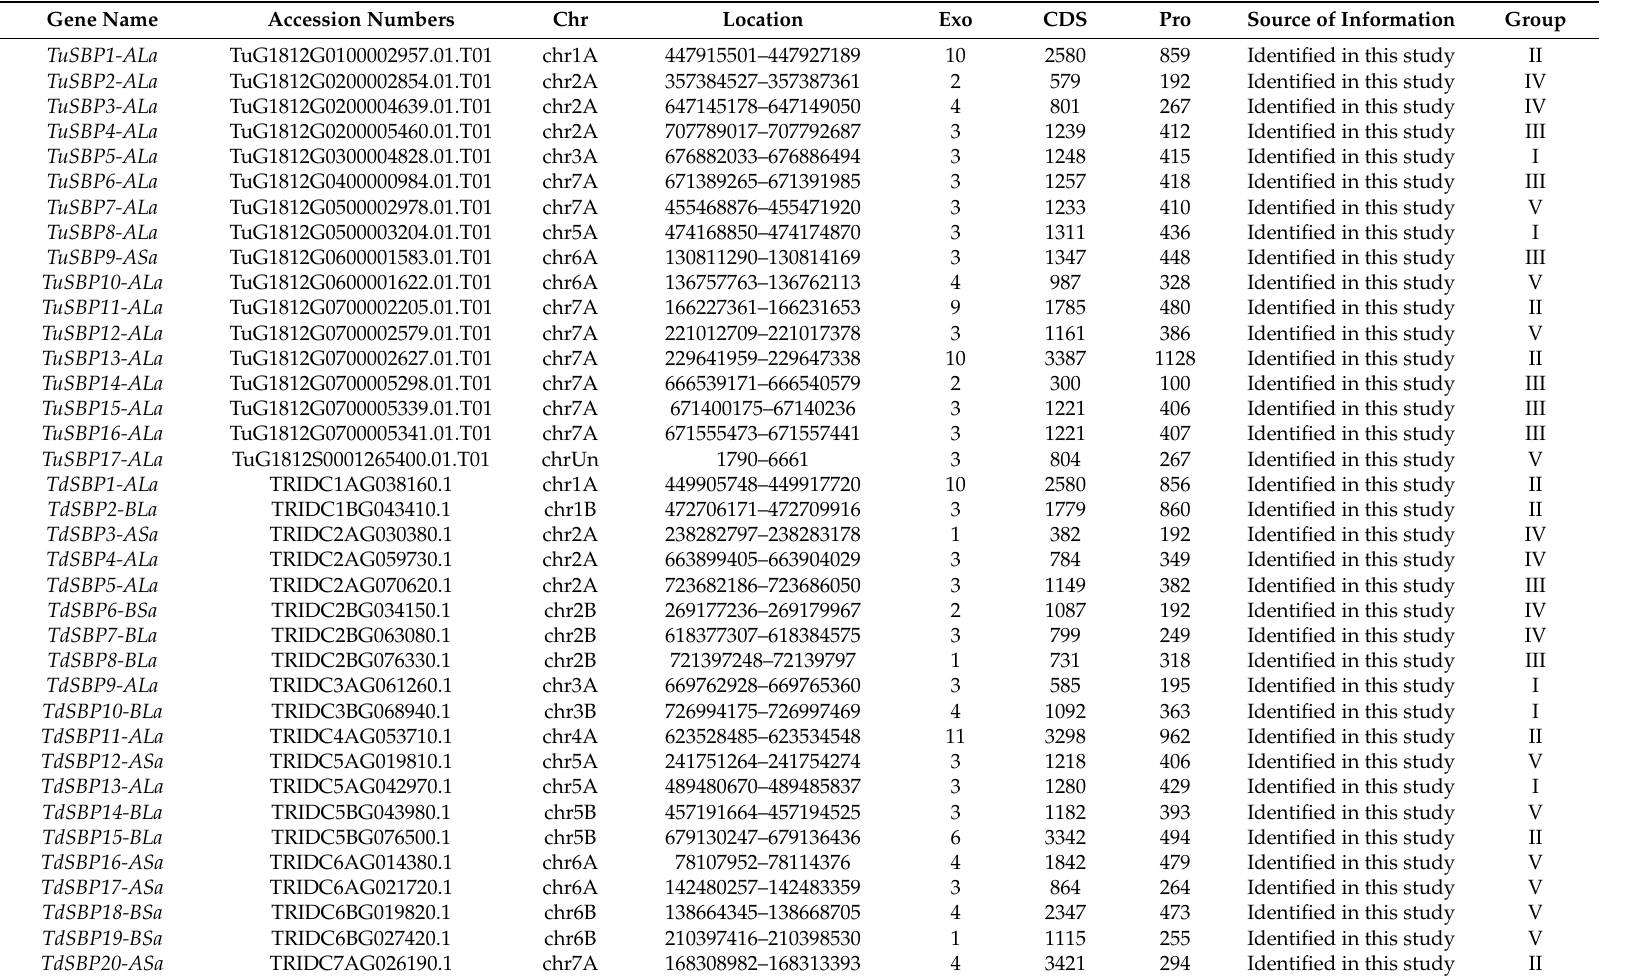
Table 2. General information of SBP proteins selected for diploid and tetraploid